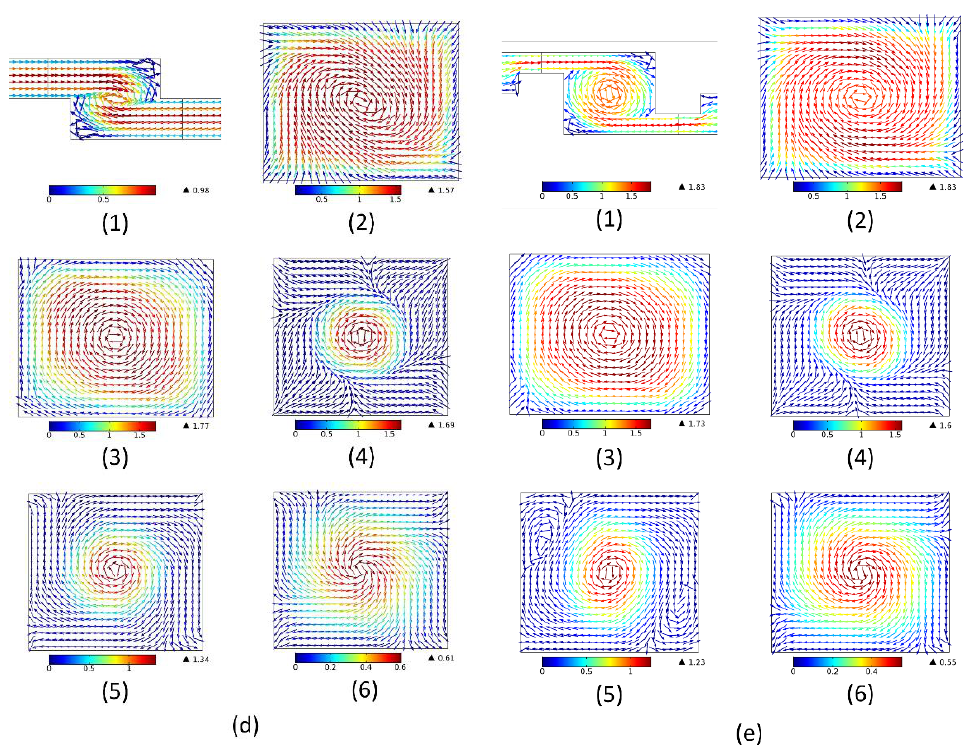
Figure 10. ( a ) The selected planes on four micromixers. (1) x = −0.05 mm, (2) x = 0 mm, (3) x = 0.1 mm, (4) x = 0.2 mm, (5) x = 0.5 mm, (6) x = 1 mm. Arrow surface of transversal flows at Re = 50 ( b )